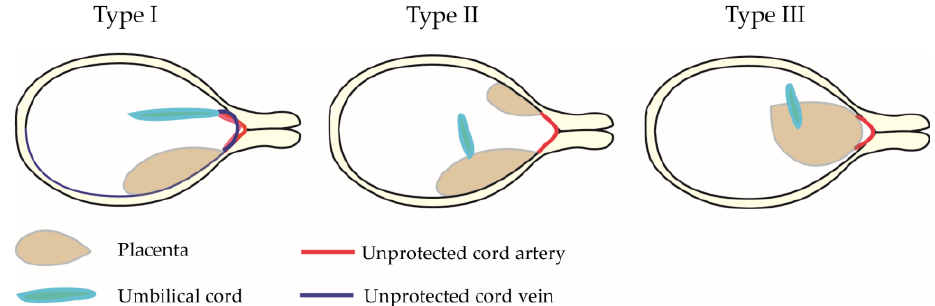
Figure 2. Schema of type I, II, and III vasa previa. The passage of unprotected blood vessels across or near the internal cervical os is common to all three types. Typical characteristics of type I, II, and III vasa previa are shown in the scheme. In general, type I is caused by velamentous cord insertion, type II is caused by a multilobed placenta or placenta with a succenturiate lobe, and type III is caused by a defective placenta and unprotected fetal vessels running outside of the placenta.